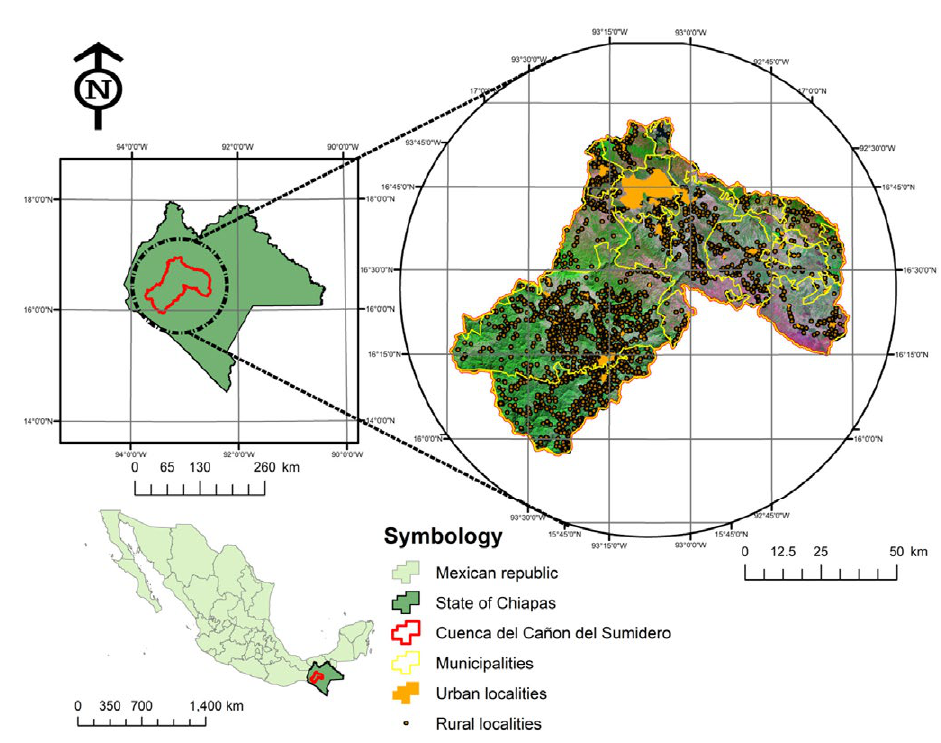
Fig. 1 : Geographic location of the study area in Cuenca del Cañón de Sumidero in Mexico